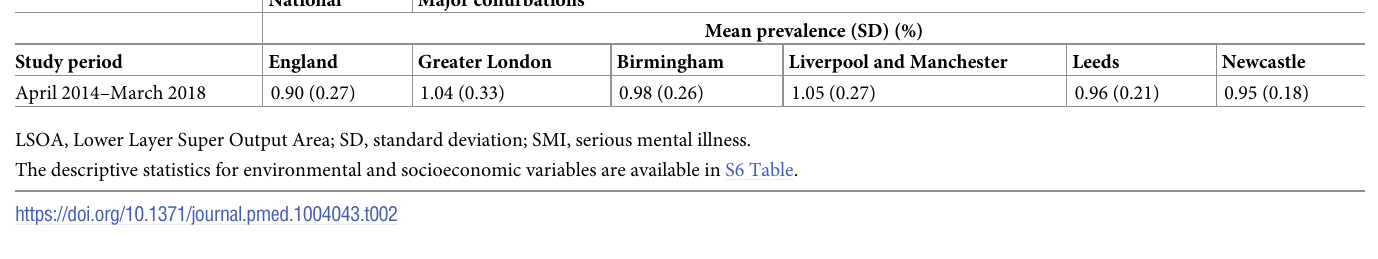
Table 2. LSOA-level mean SMIs prevalence (% average (SD)) for the studied period (April 2014–March 2018) in England and major conurbations. National Major conurbations Mean prevalence (SD) (%) Study period England Greater London Birmingham Liverpool and Manchester Leeds